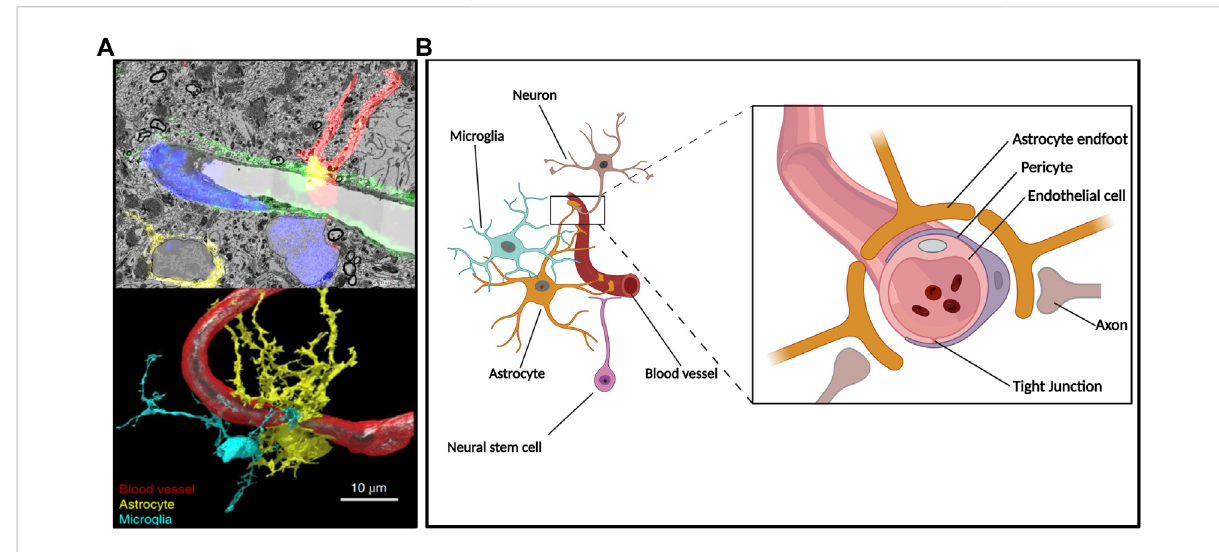
FIGURE 1 Theneuro-angiogenicnicheandtheNVU.ConstitutivecomponentsoftheNVUresideinamicroenvironmentwheresecretedfactors,cell-cell interactions,andvascularsupplygiverisetoaninterdependentunit. (A) HippocampalNVUcomprisingbloodvesselsandsurroundingtissuedepicted throughout acompositionofelectron microscopy-acquiredsectionsandits correspondingconfocalmicroscopy fl uorescence image(upperpanel) as well as subsequent 3D reconstruction (lower panel); reproduced with permission (Fang et al., 2018). (B) Simpli fi ed diagram depicting components of the BBB at a neurogenic region where radial glia-like NSC are in direct contact with the